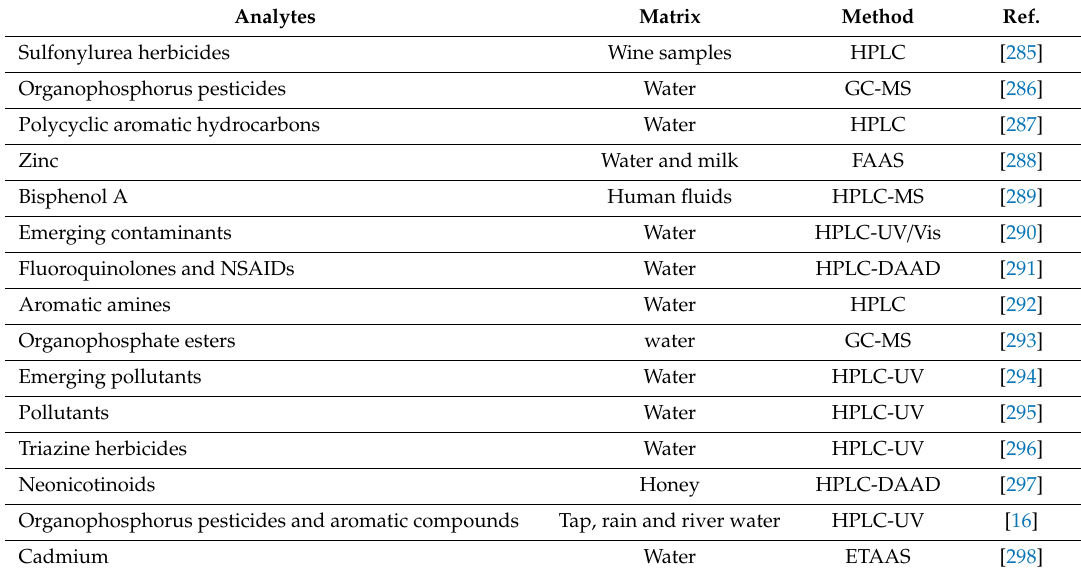
Table 3. Examples of applications of ionic liquids (ILs) for sample